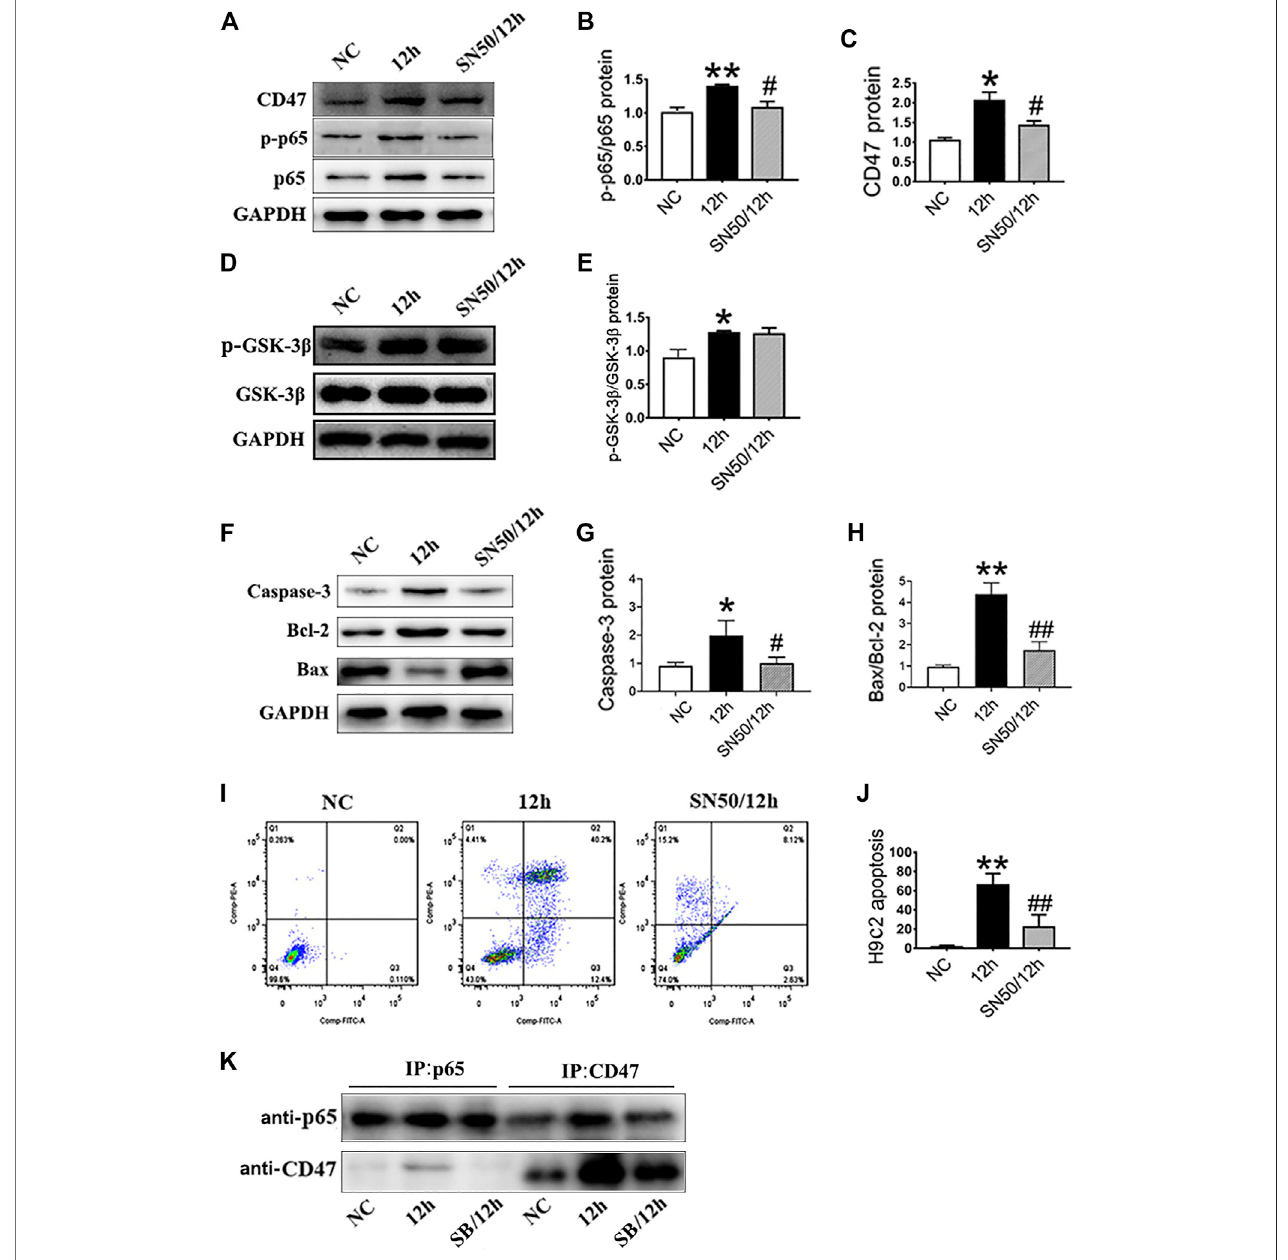
FIGURE 6 | GSK-3 β participates in CD47 upregulation and apoptosis via NF- κ B signaling in H9c2 cells. (A – E) . Expressions of CD47, p-p65/p65 NF- κ B, and p-GSK-3 β /GSK-3 β in H9c2 cells under hypoxic conditions, as measured using western blot following SN50 pretreatment. (F – H) Western blot analysis of caspase-3, Bcl-2 and Bax expressions in hypoxic H9c2 cells. (I, J) Flow cytometry showed a decrease in the apoptosis rate in hypoxic H9c2 following SN50 pretreatment ( n (cid:2) 3/ group). (K) H9c2 cell lysates were immunoprecipitated with anti-CD47 antibody or anti-p65 antibody, and the resulting immune complexes were analyzed by western blot using various antibodies, as indicated. Data are presented as the mean ± SD. *p < 0.05, ** p < 0.01 vs. NC; # p < 0.05, ## p < 0.01 vs. 12 h.